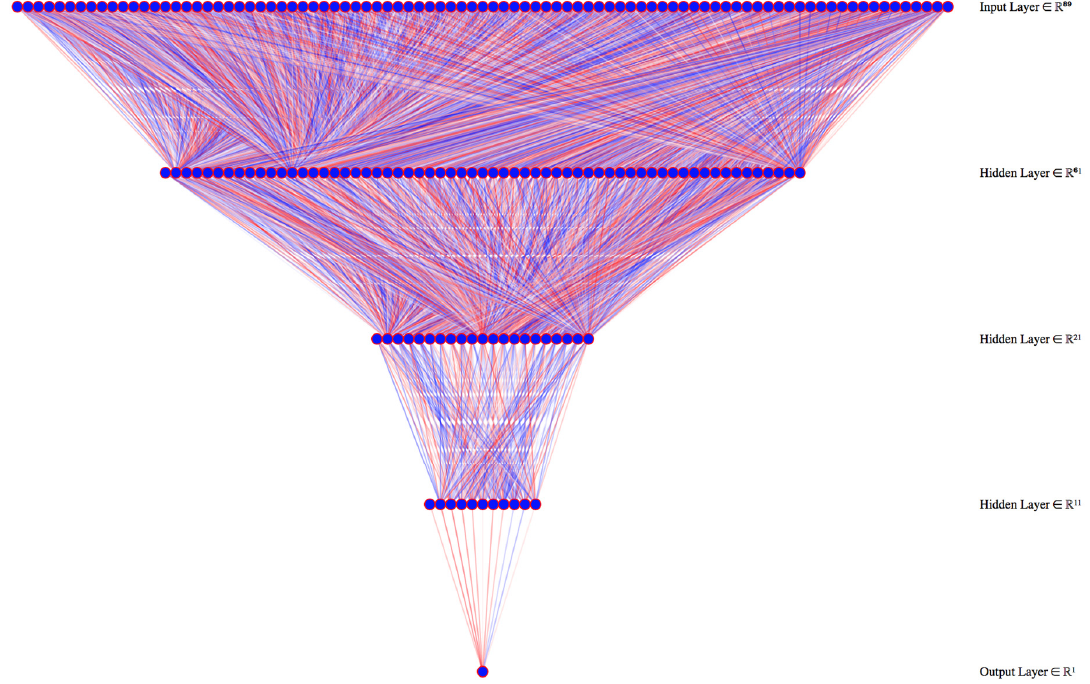
Figure 3. Deep learning model architecture for annual per capita waste production. We used 800 learning epochs were used to train the